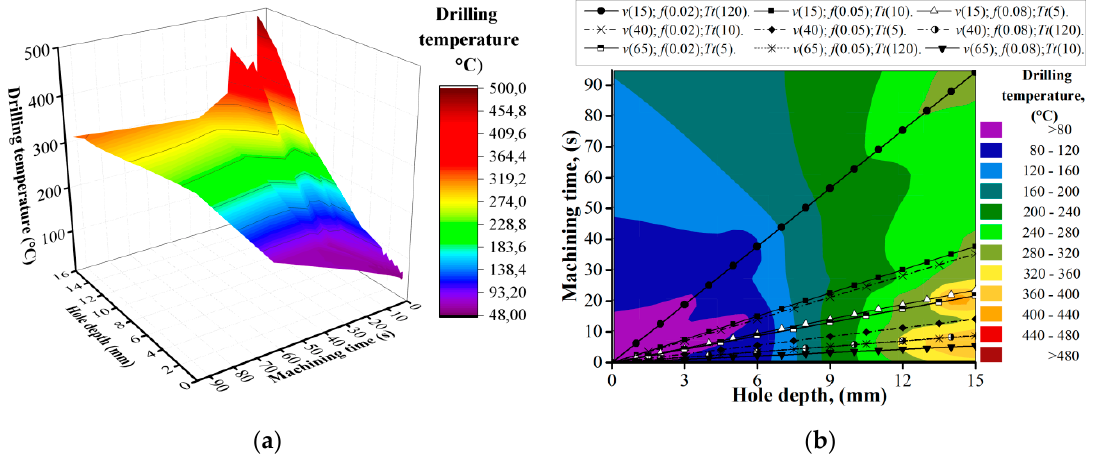
Figure 4. Drilling temperature when machining hole No. 1 in CFRP/Ti alloy stack; ( a ) evaluation of drilling temperature depending on machining time and hole depth; ( b ) Drilling Temperature Plane Projection.